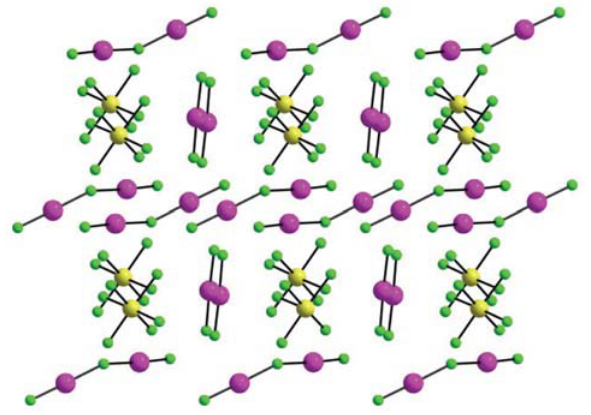
][ RuF ] ·XeF F . 2 3 6 2